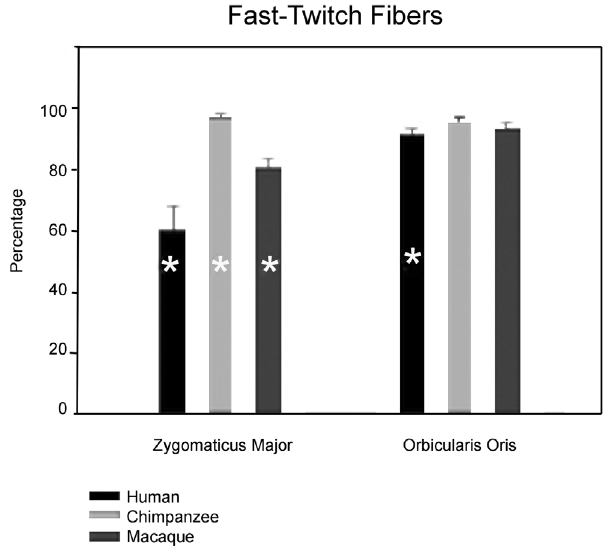
Figure 3. Percentages of slow-twitch myosin fibers in facial muscles. Results of one-way ANOVA and post-hoc Least Squares Difference testing in the orbicularis oris muscle indicate that humans have the highest percentage of slow-twitch myosin fibers (human . chimpanzee=macaque) at the p , 0.05 level of statistical significance. For the ZM, Least Squares Difference testing was unable to separate chimpanzees from humans at the p , 0.05 level of statistical signifi- cance. The presence of a ‘‘*’’ indicates that the group mean percentage was significantly different from the other groups. Means with SEM are